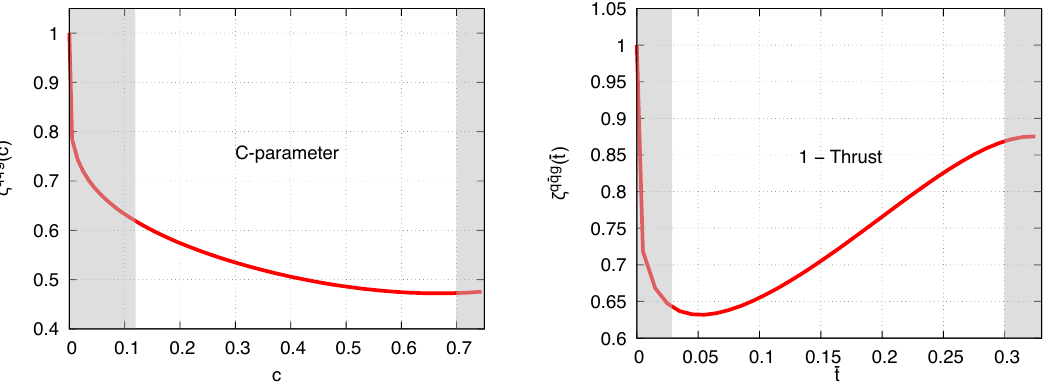
Figure 3 . Same as figure 1, but for the sum of all the dipoles, where each contribution is supplemented with the proper colour factor, as in eq. (6.6). The grey shading shows the region which is usually excluded from α s determinations